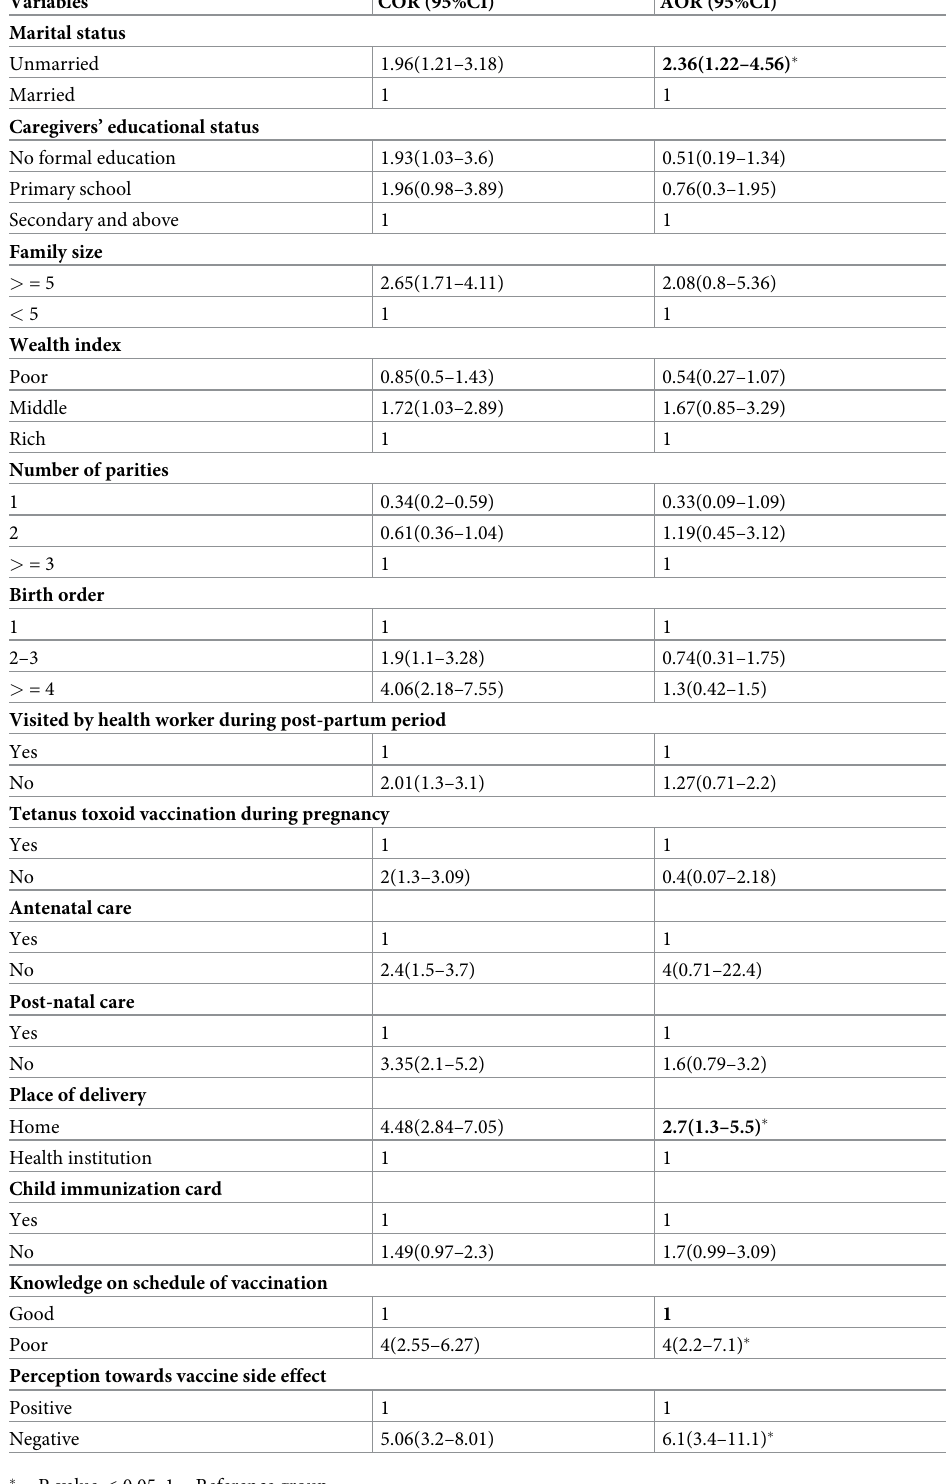
Table 5. Determinants of incomplete immunization among children 12–23 months in Dabat district, Northwest, Ethiopia,